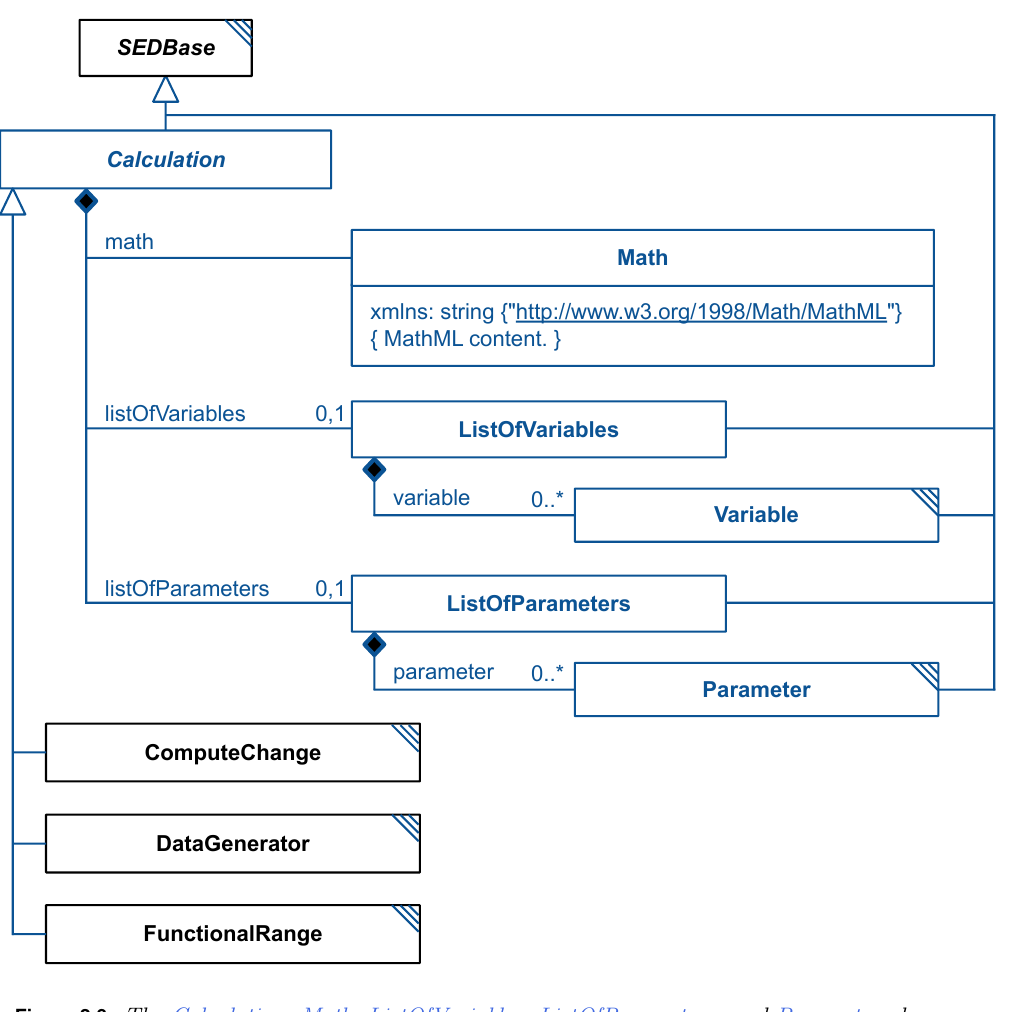
Figure 2.6: The Calculation, Math, ListOfVariables, ListOfParameters, and Parameter